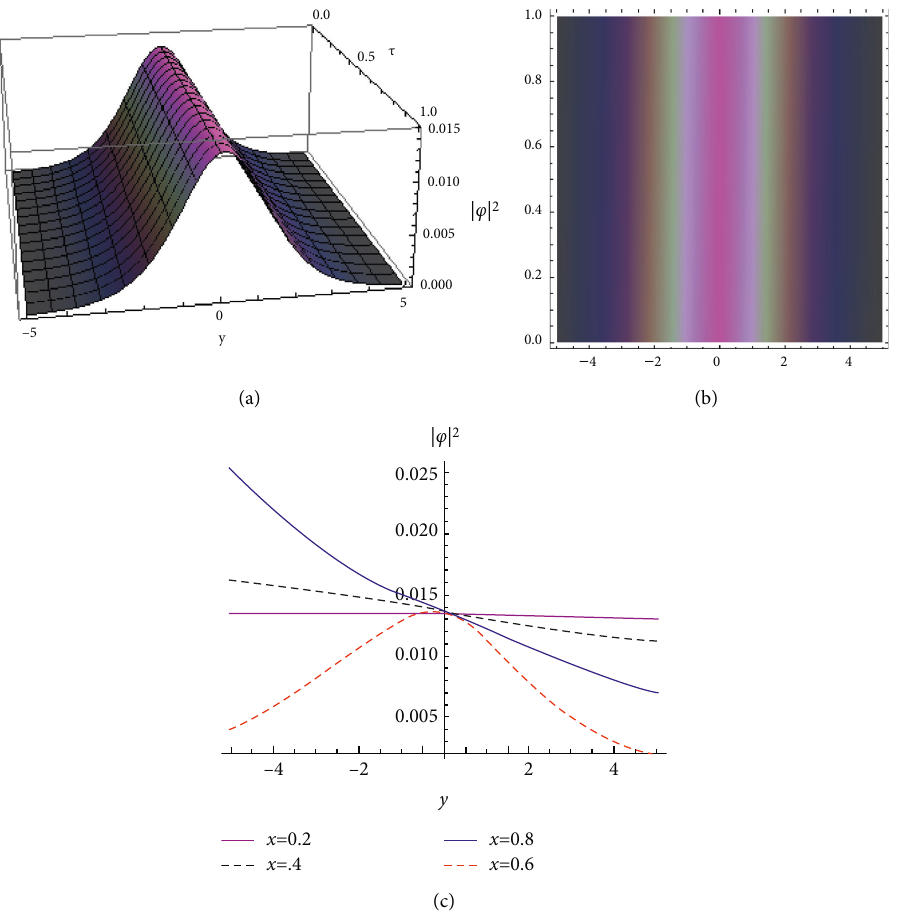
� ς � ω � 1, ς � 0 . 5 � δ , ς � 0 . 4, N � 31, λ � 5, k � 0 . 1, β � 0, and χ � 0 . 2 , 0 . 4 , 0 . 6 , 0 . 8. For the 1 4 2 3